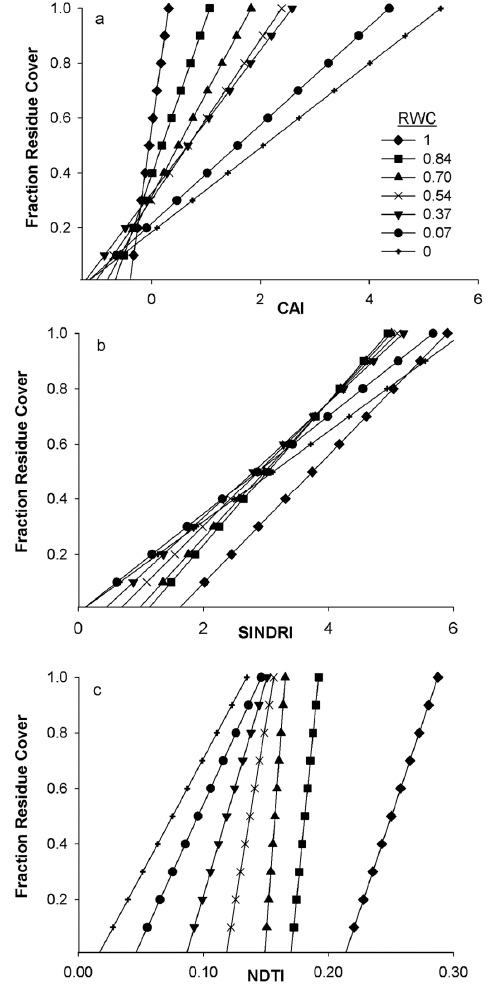
Figure 5. Residue cover as a function of ( a ) CAI; ( b ) SINDRI and ( c ) NDTI for simulated scenes of maize residues on Matawan soil for RWC ranging from dry to saturated.